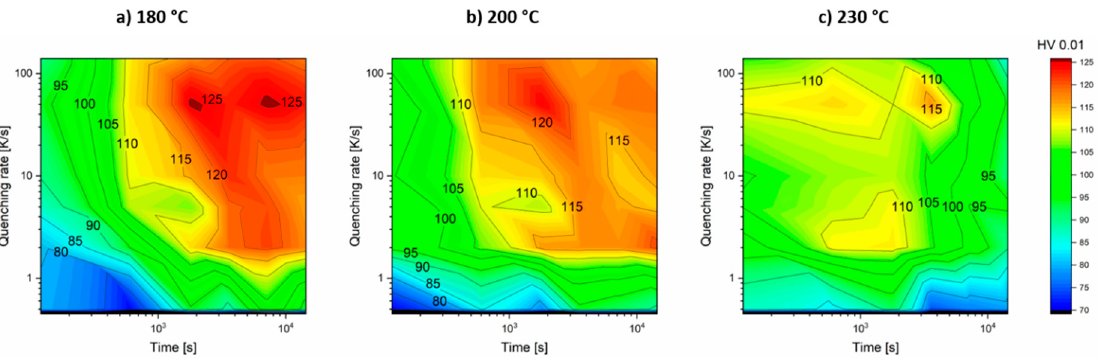
Figure 2. Contour plots of ISO hardness values as a function of the quenching rate and aging time for ( a ) 180 °C, ( b ) 200 °C, ( c ) 230 °C. Table 1. Measured chemical composition of the AlSi 7 Cu 0.5 Mg.